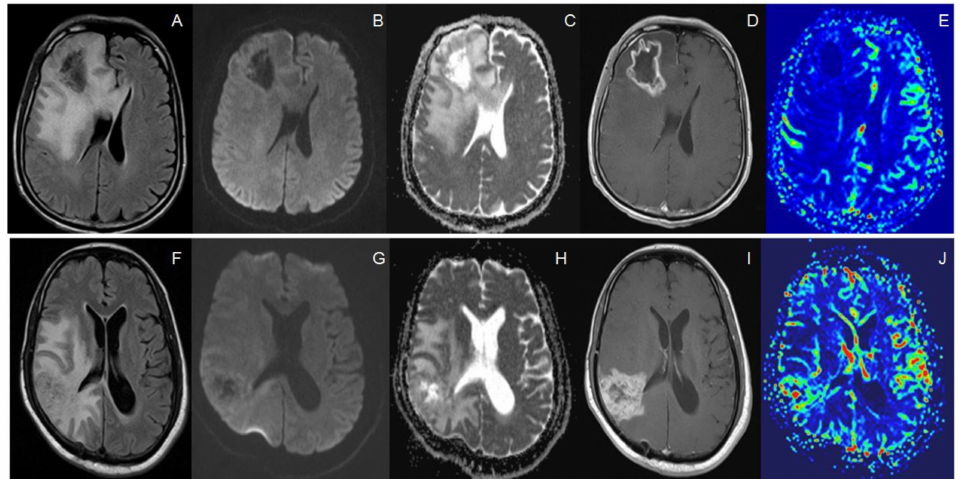
Figure 1. ( A – E ): Post op cavity with perilesional edema on FLAIR sequence ( A ), showing foci of diffusion restriction ( B ) with corresponding low ADC ( C ) and nodular peripheral margin enhance- ment ( D ). No abnormal areas of perfusion were seen ( E ). Histopathology showed radiation induced